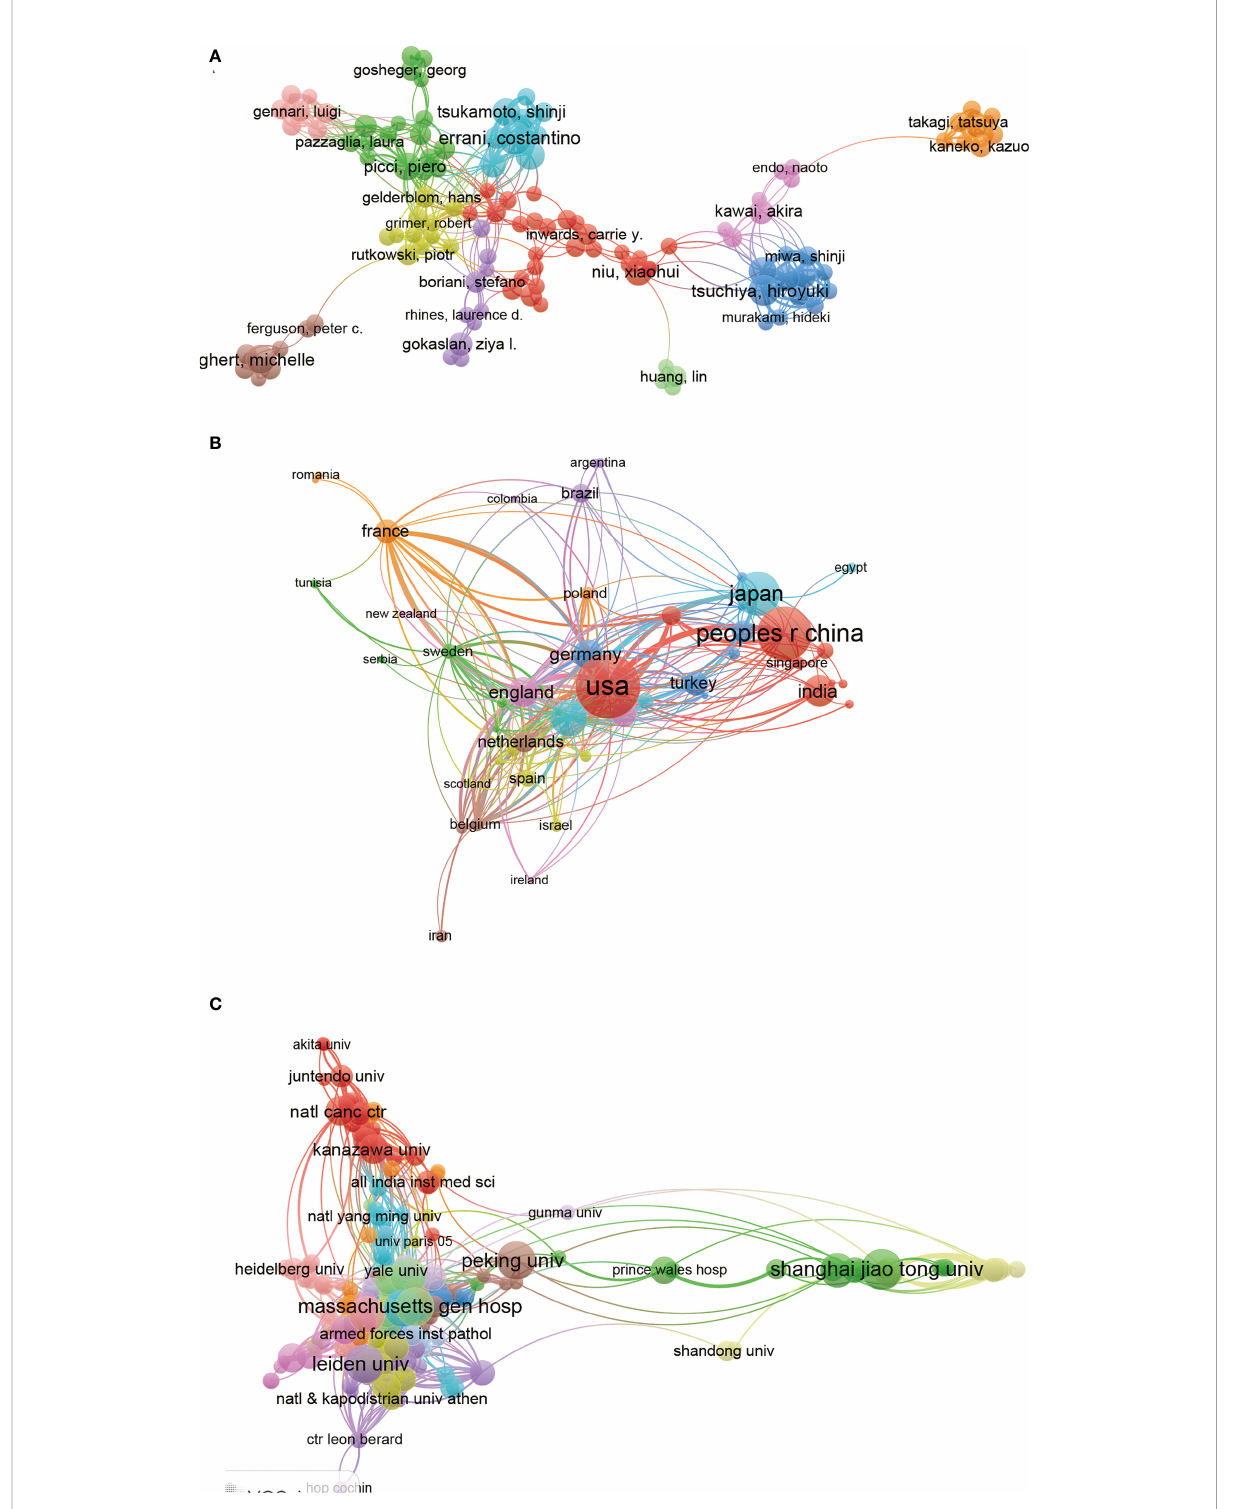
FIGURE 7 Visualized images of co-authorship analysis of global research about GCTB. (A) Mapping of the 119 author co-authorship analysis on GCTB. (B) Mapping of the 50 country co-authorship analysis on GCTB research. (C) Mapping of the 231 institution co-authorship analysis on GCTB